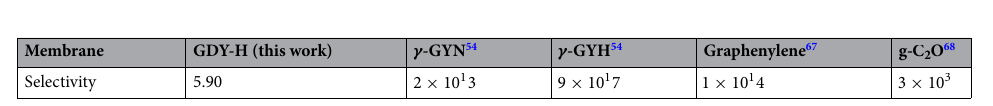
Table 1. H 2 / CO 2 selectivities for GDY-H membrane and other proposed membranes at room temperature (300